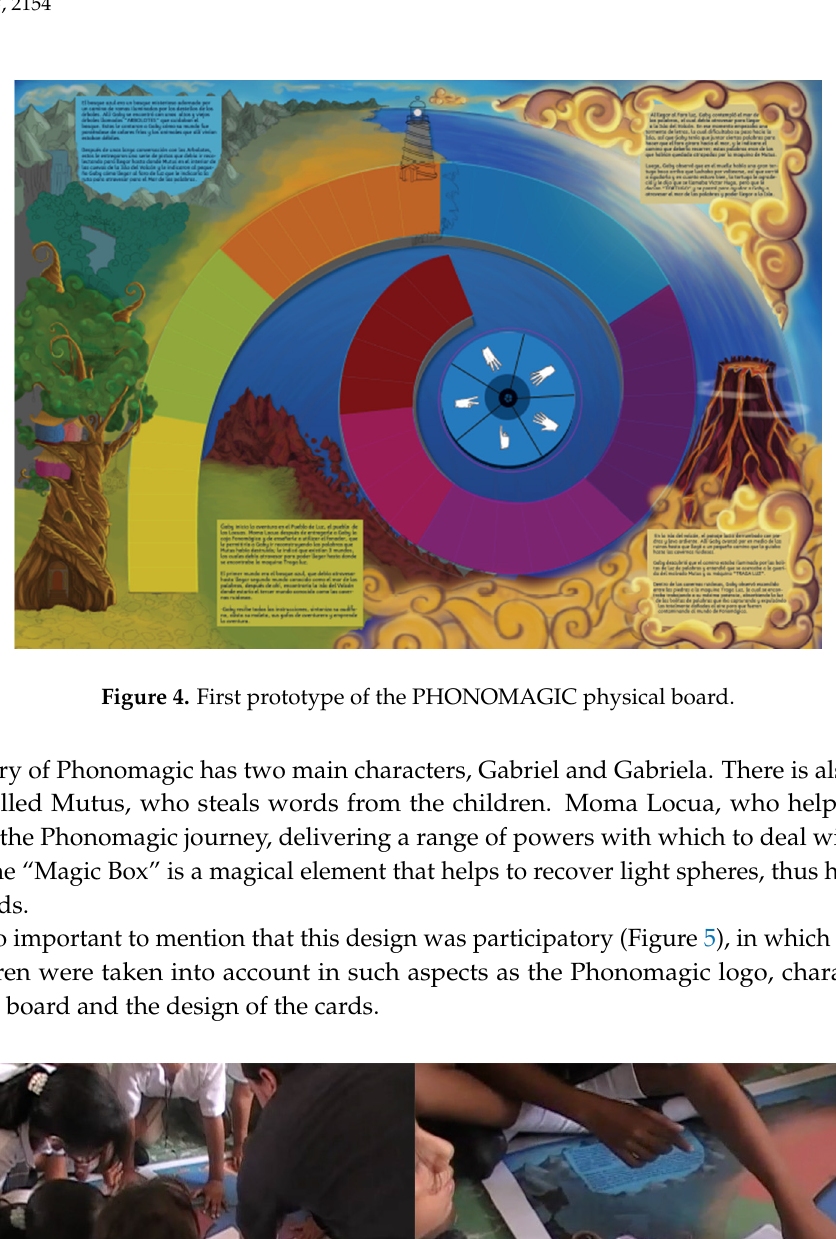
Figure 6. Interaction phono ‐ cards with RFID + Tablet. The connectivity used for this type of interaction with IoT technologies is Device ‐ to ‐ Device. Connection is made between the nano ‐ Arduino and the mobile device (Tablet) via Bluetooth. As such, the electronic components are implemented inside a box that has the shape of a “magic box” according to the PHONOMAGIC story. The “magic box” inside the story, is a magical element that